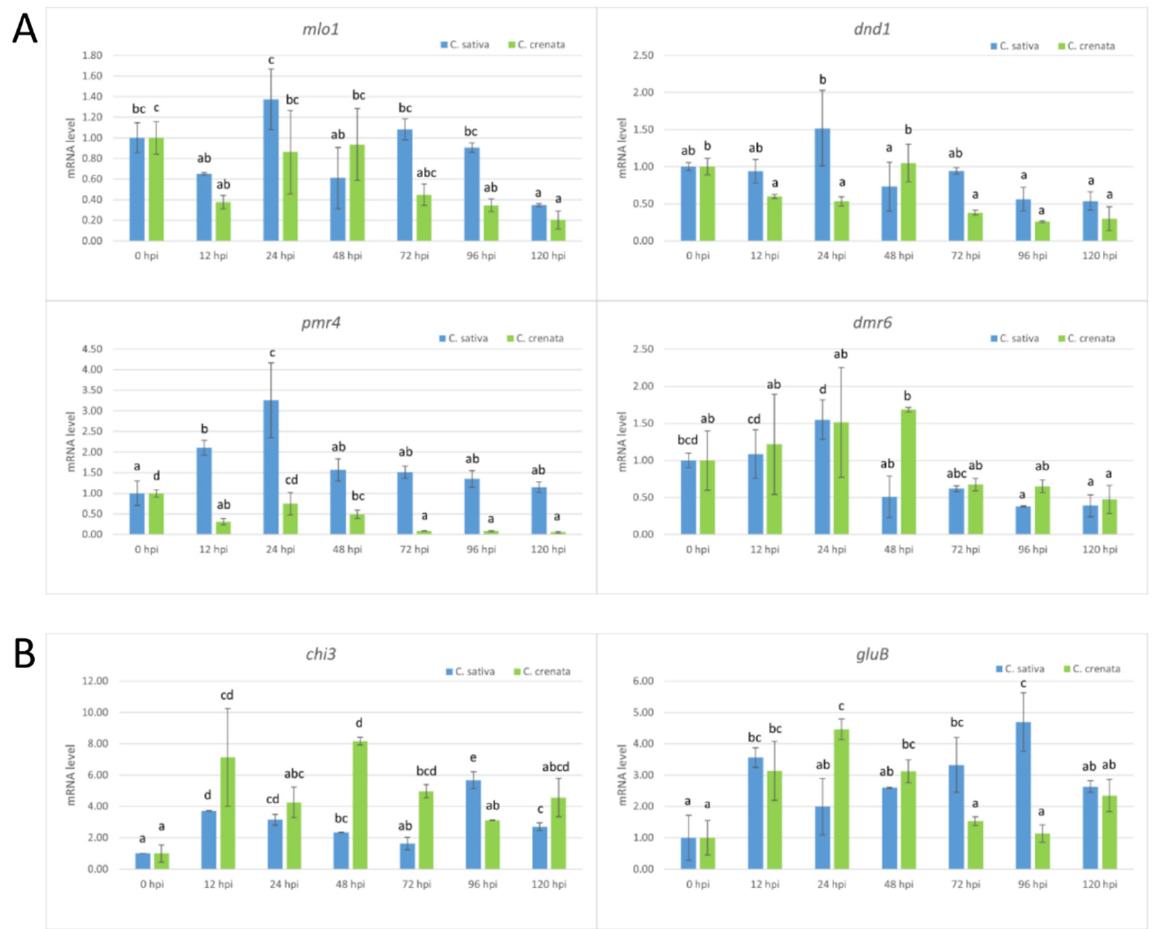
Figure 7. qRT-PCR-based transcription profiling after C. parasitica inoculation. ( A ) The S-gene transcription profile in C. sativa (blue) and C. crenata (green) chestnut species. ( B ) The expression analysis of genes coding for several pathogenesis- related (PR) proteins of C. sativa (blue) and C. crenata (green) species. In all the analyses, Cm7-actin was used as the housekeeping gene. The data are the means of three biological replicates ± SE. C. sativa data are normalized with C. sativa 0 hpi control; C. crenata data are normalized with C. crenata 0 hpi control. Different letters associated with the set of means indicate a significant difference based on Tukey’s HSD test ( p ≤ 0.05).